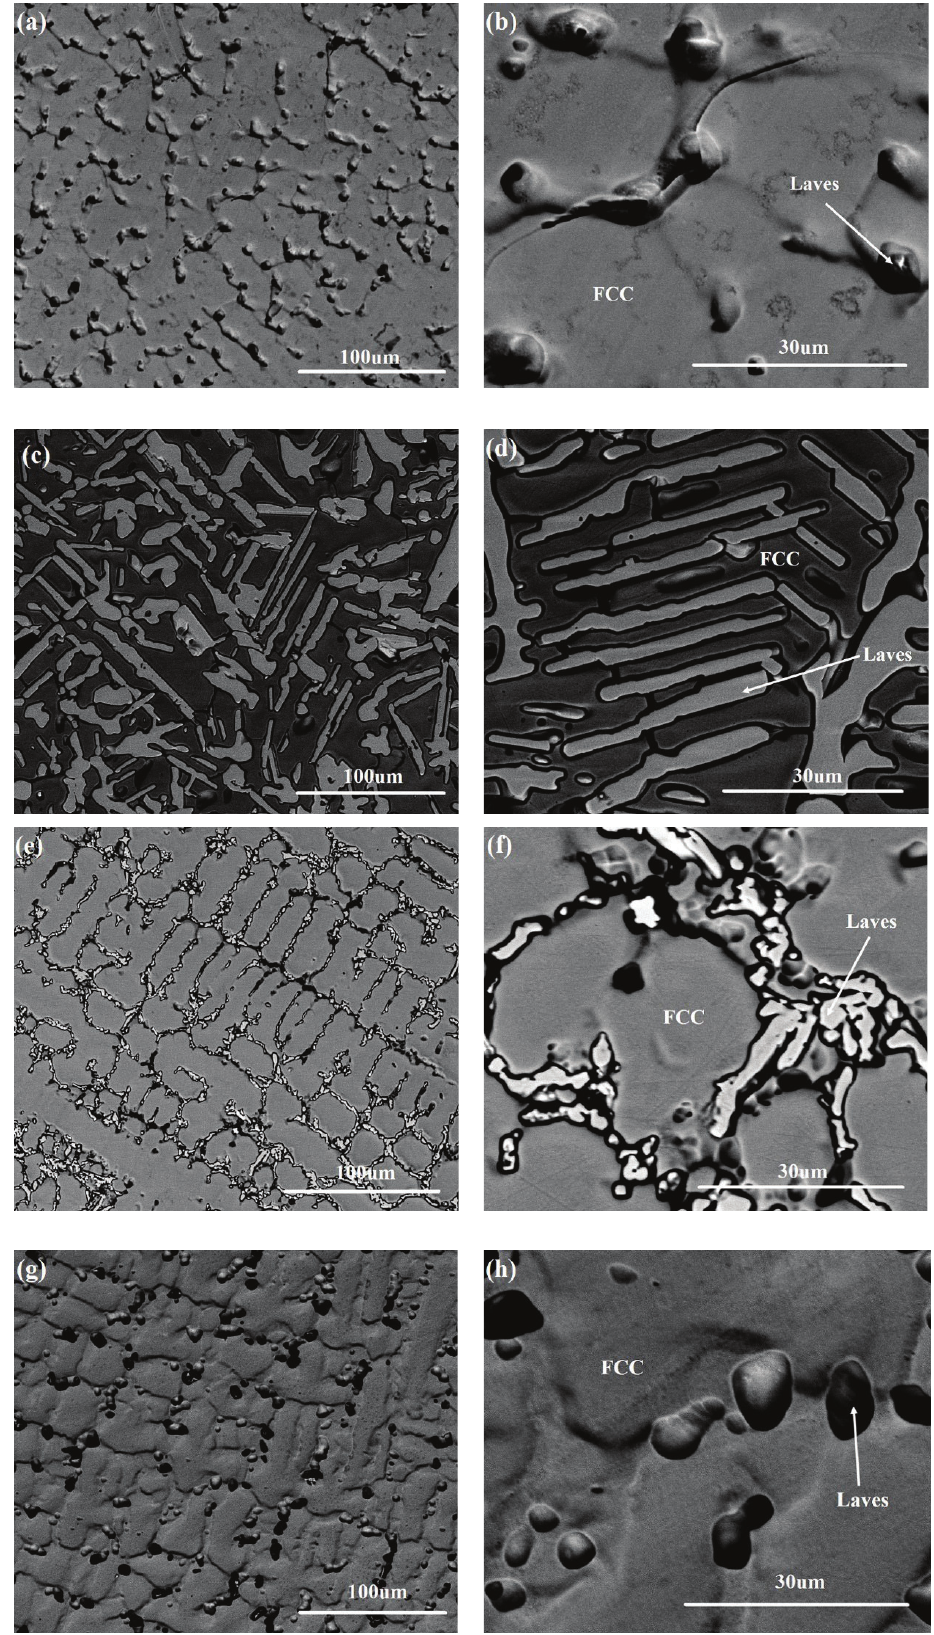
Figure 3. SEM BSE images of CoFeNiMnMo x alloys. ( a , b ) x = 0.25, ( c , d ) x = 0.50, ( e , f ) x = 0.75 and ( g , h ) x = 1.00. Table 1. Chemical compositions of various phases in CoFeNiMnMo x alloys in atomic percentage.